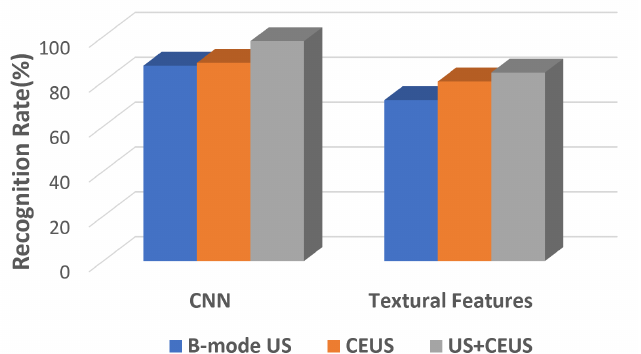
Figure 7. Comparison of the classification accuracy values achieved in each case by the CNN-based techniques or through the conventional approach.